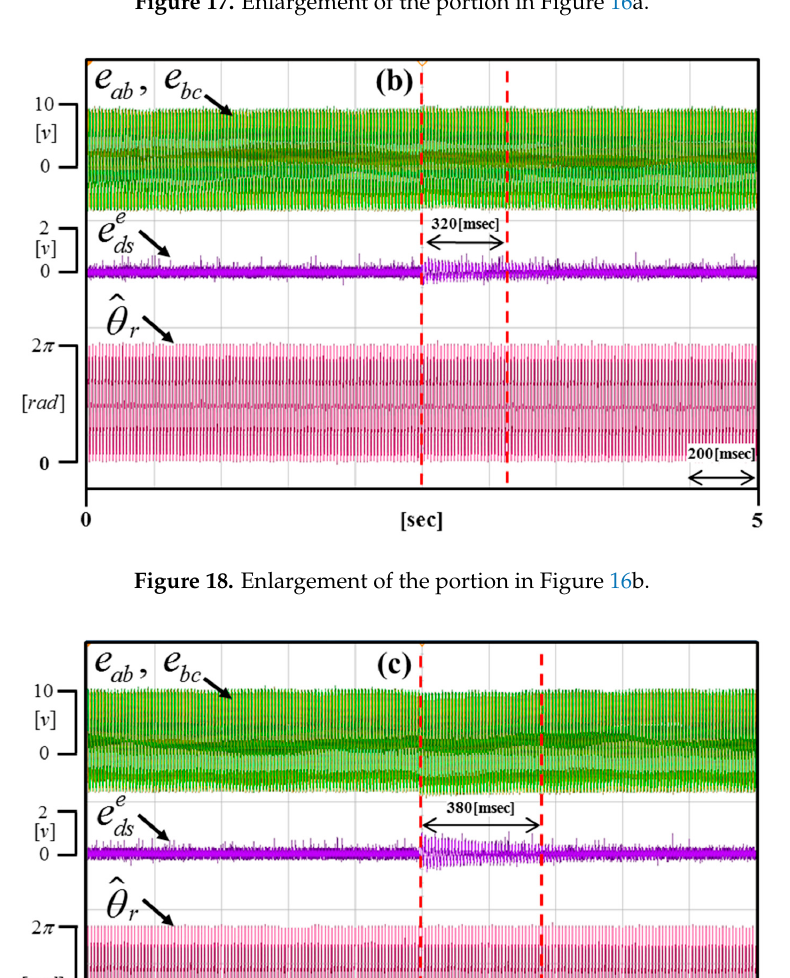
Figure 17. Enlargement of the portion in Figure 16a. Energies 2017 , 10 , 1160